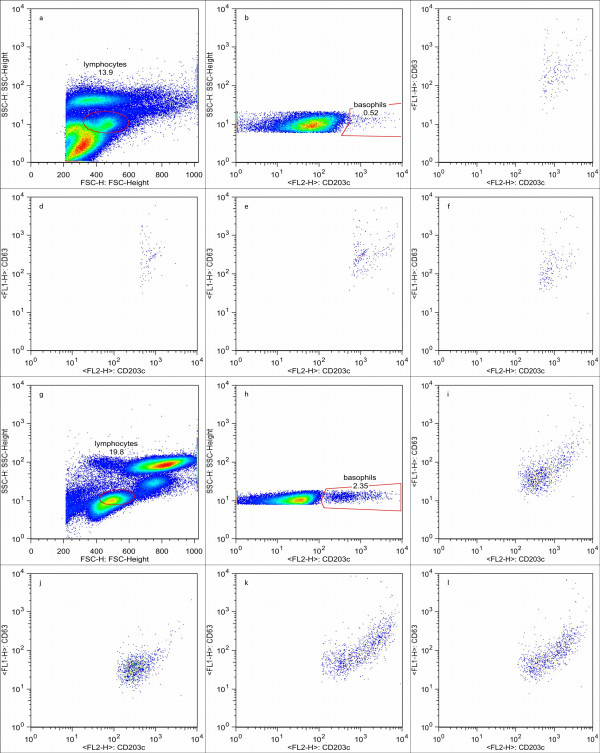
Analysis of Basophil activation. Analysis of basophils after lysis by Immunoprep/Q-prep (a–f) or WBL (g–l) of a representative donor. By dynamic backgating (illustrated in figure 2), the region in a forward scatter vs side scatter plot in which basophils are located was optimised (a & g). CD203c+ cells were identified in this gate (b & h), and the expression of CD203c and CD63 was evaluated (c & i). CD203c vs CD63 expression at differend concentrations of CRA1 is shown after both lysis conditions (1 ng/ul panels c, g, 0,001 ng/ul in panels f & l, 0, 0,0001 in panels e & k; pbs in panels d & j).